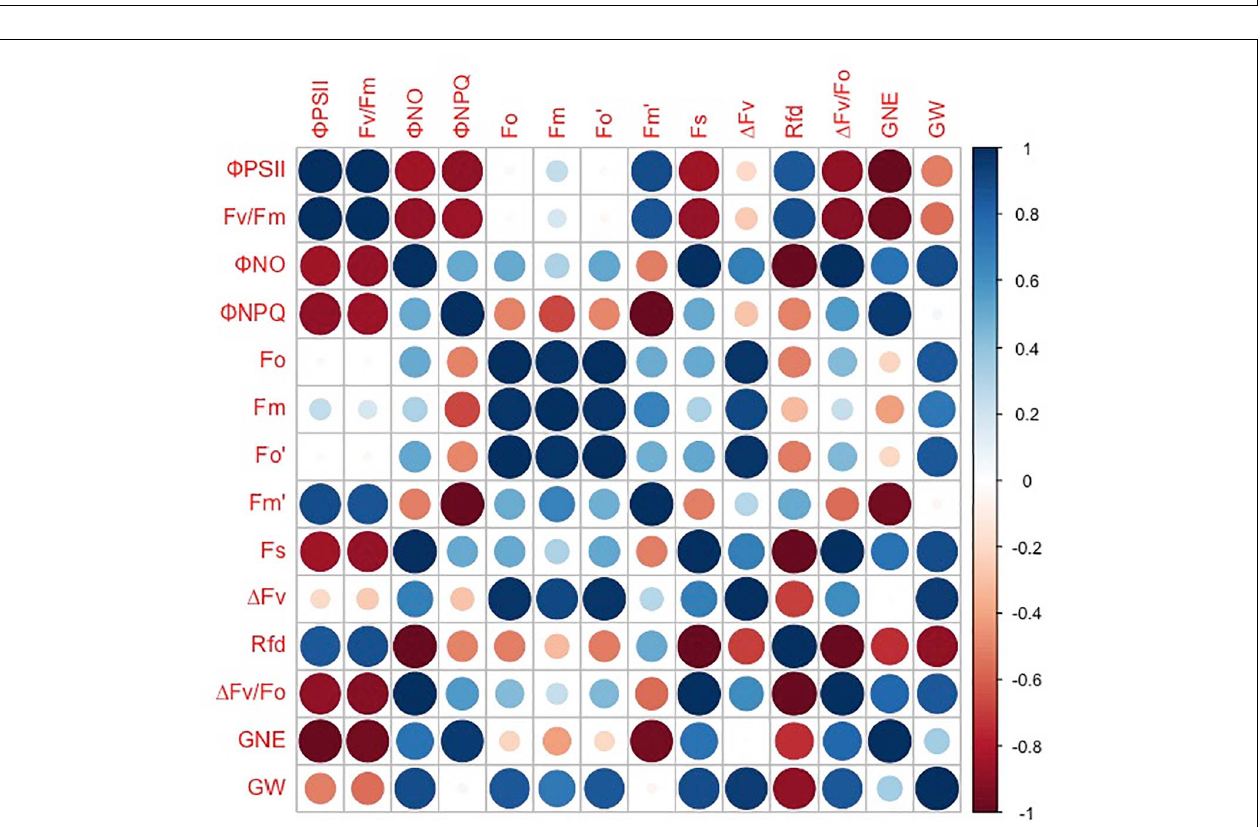
FIGURE 7 | Correlations between grain number per ear (GNE), 1,000-kernel weight (GW), (cid:56) PSII , Fv/Fm, (cid:56) NO , (cid:56) NPQ , Fo, Fm, Fo (cid:48) , Fm (cid:48) , Fs, (cid:49) Fv, Rfd, and (cid:49) Fv/Fo in SH8675. Spearman’s rank correlation coefficient-based correlograms of the measured parameters on plants grown under elevated CO 2 . The color of each square indicates the value of the correlation coefficient for each pair of traits following the color scale of the vertical color bar. The red and blue circles indicate negative or positive correlations between parameters, respectively.